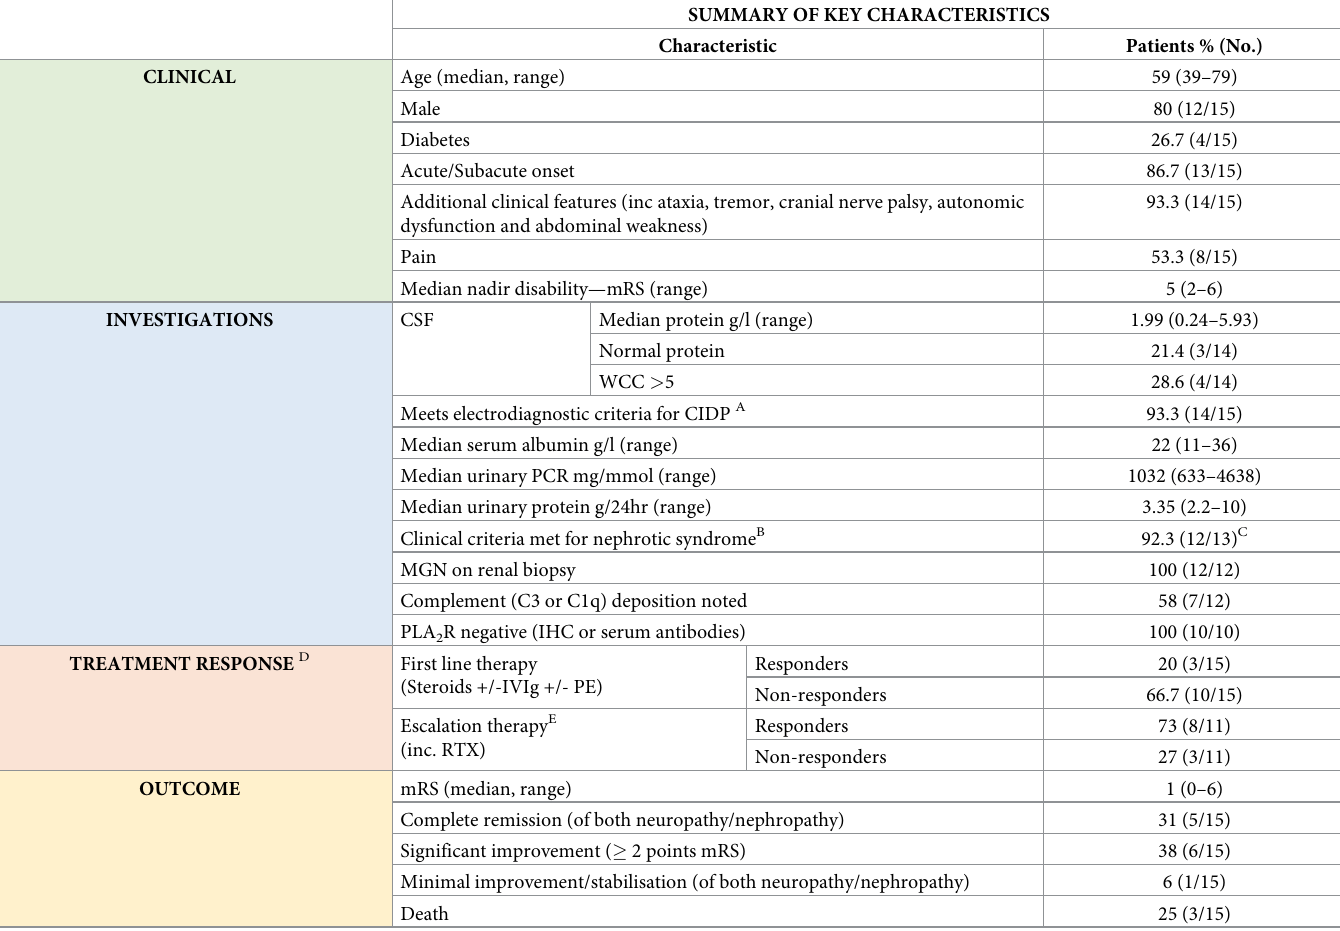
Table 1. Summary of patients with neuropathy, nephrotic syndrome and CNTN1